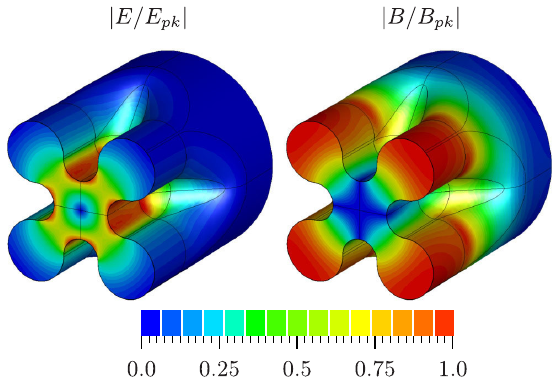
FIG. 12. Normalized field magnitude of the TE like quadrupole mode on the surface and in the transverse plane at the longitudinal center of a four-vane